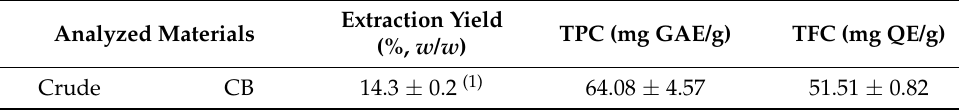
Table 1. The extraction yields, total phenolic content (TPC), and total flavonoids content (TFC) in crude ethanolic CB